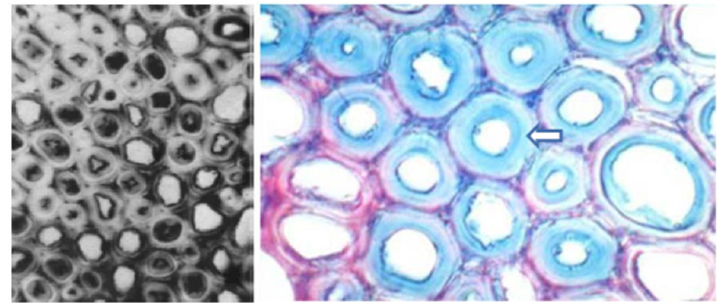
Figure 12. The gelatinous fibers of Thyrsostachys oliveri (the arrow indicates the gelatinous layer) [81].